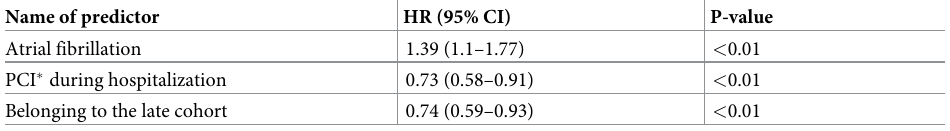
Table 2. Multivariable predictors of ischemic